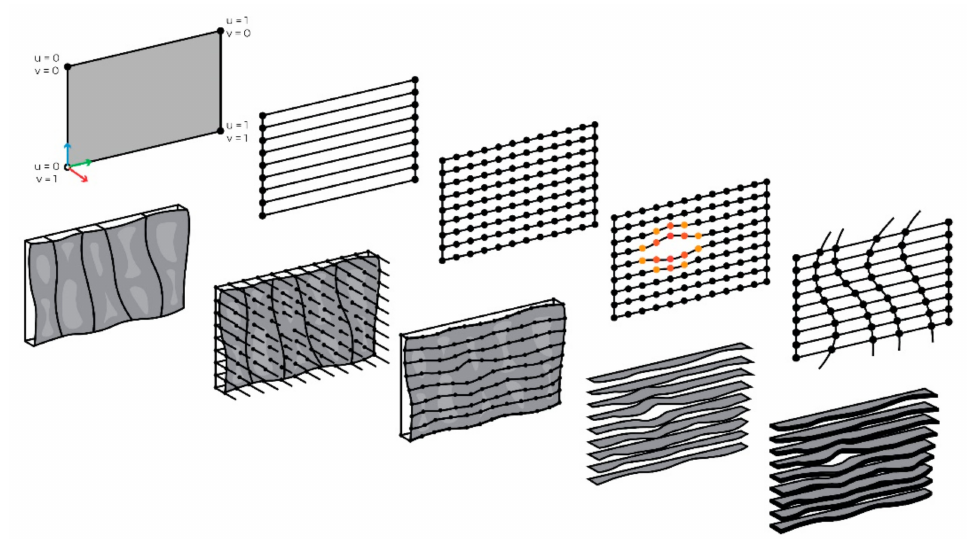
Figure 6. Computational model build process in Dynamo.